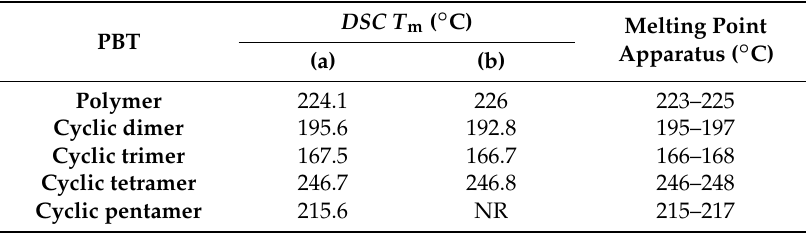
Table 2. Differential scanning calorimetry (DSC) results for all four isolated PBT cyclic oligomers, from dimer to pentamer.